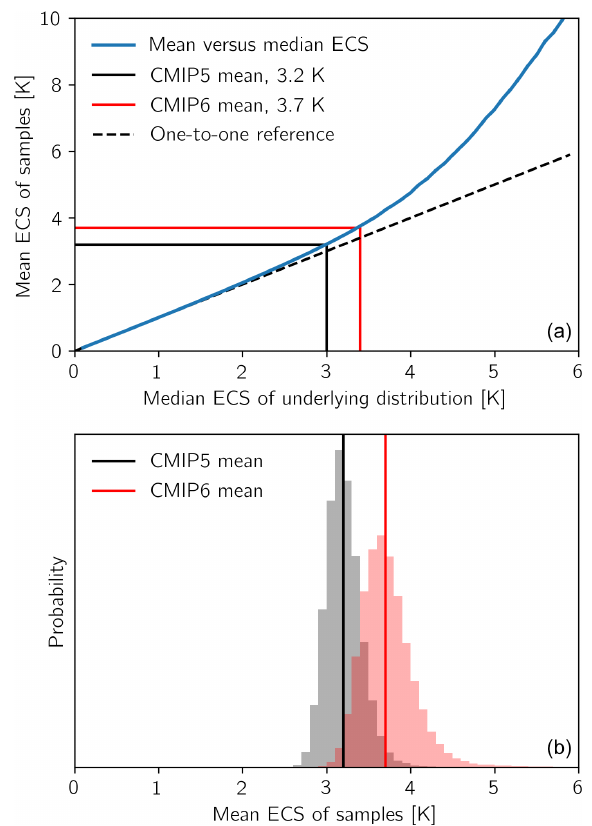
Figure 3. Random sampling of ECS from Gaussian distributions of λ and F 2 x . Panel (a) shows the relationship between the median and mean of ECS, arising from the inverse relationship between ECS and λ . Panel (b) shows distributions of mean ECS from random 25- member ensembles centered at the means of CMIP5 and